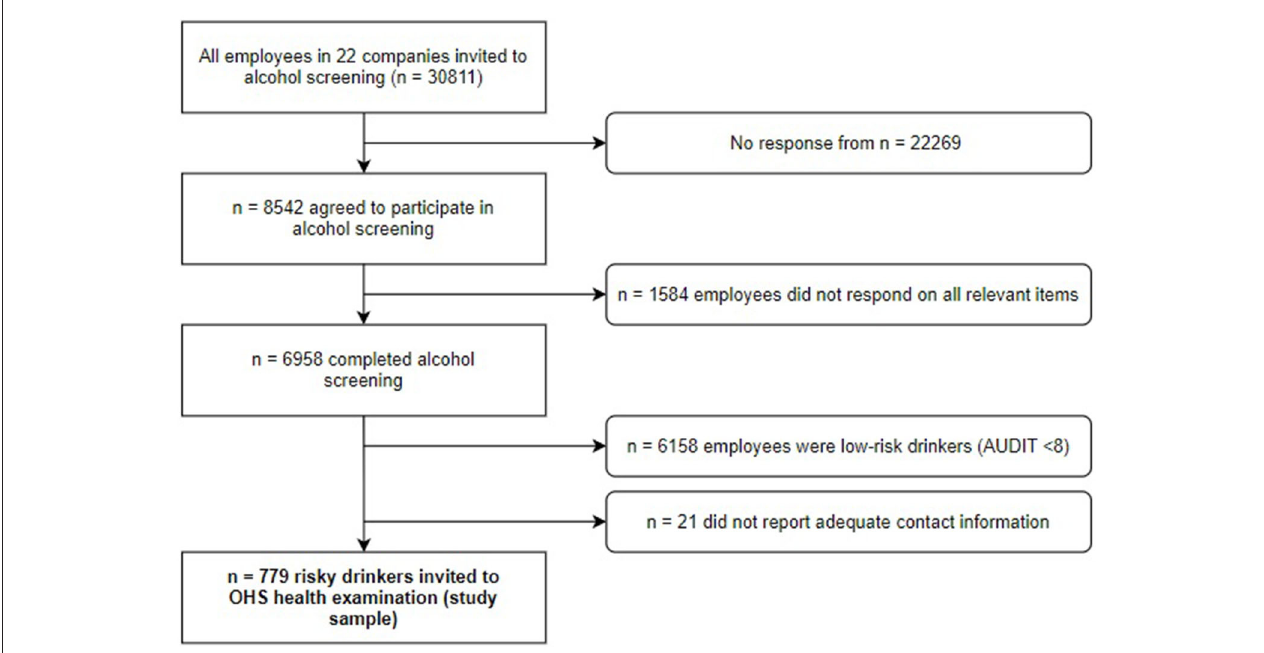
FIGURE 1 | Flow chart depicting the process of participant recruitment. AUDIT, Alcohol Use Disorders Identification Test; OHS, occupational health services.